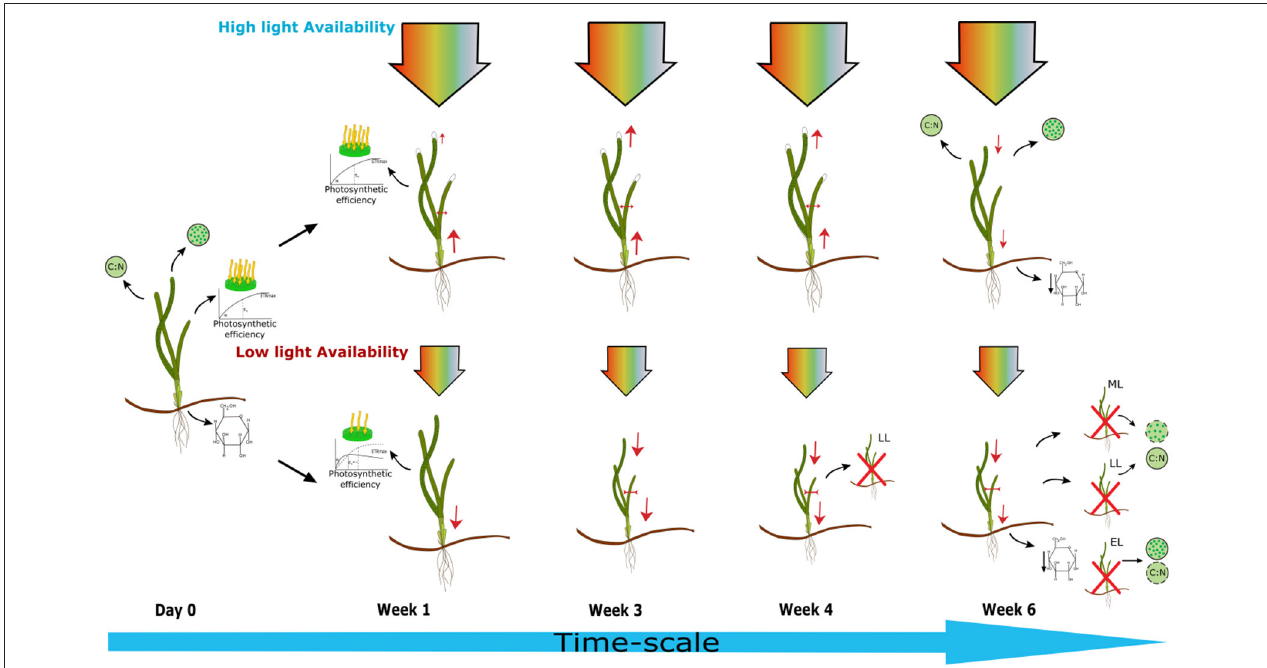
FIGURE 5 | Schematic diagram showing effects of light limitation on Zostera marina plants over time under experimental conditions. High light treatment (HL) = 5.61mol photons m − 2 day − 1 , light limiting treatment < 0.73mol photons m − 2 day − 1 (ML = medium light 0.73, LL = low light 0.35, EL = extreme low light treatments 0.14mol photons m − 2 day − 1 ). Within the first week photosynthetic efficiency was affected in shaded plants shown by the increase in α , a decrease in ETR max and E k , along with significantly reduced shoot growth. By week 3 leaf length was reduced in all shaded plants and leaf width reduced in ML plants. By week 4 leaf width and shoot surface area were significantly reduced in all shaded plants with the death of a LL plant. By week six, HL plants also showed decreases in leaf length, shoot growth, and shoot surface area. Water soluble carbohydrate content of rhizomes was reduced in all plants at the end of the experiment. A decrease in chlorophyll content was exhibited in LL and ML plants. There was no significant change in C:N of leaf tissue recorded for any of the plants in comparison to samples taken from site location, although EL plants had the lowest ratio. Evidence of shoot mortality was found in all shade treated plants at the end of the experiment.